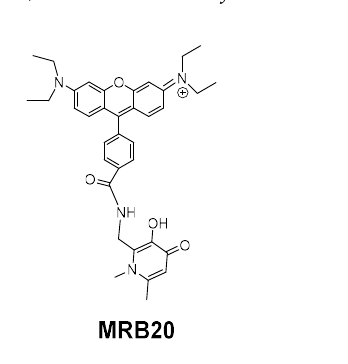
Figure 9. Formula of rosamine-derived 3,4-HPO chelator, MRB20.